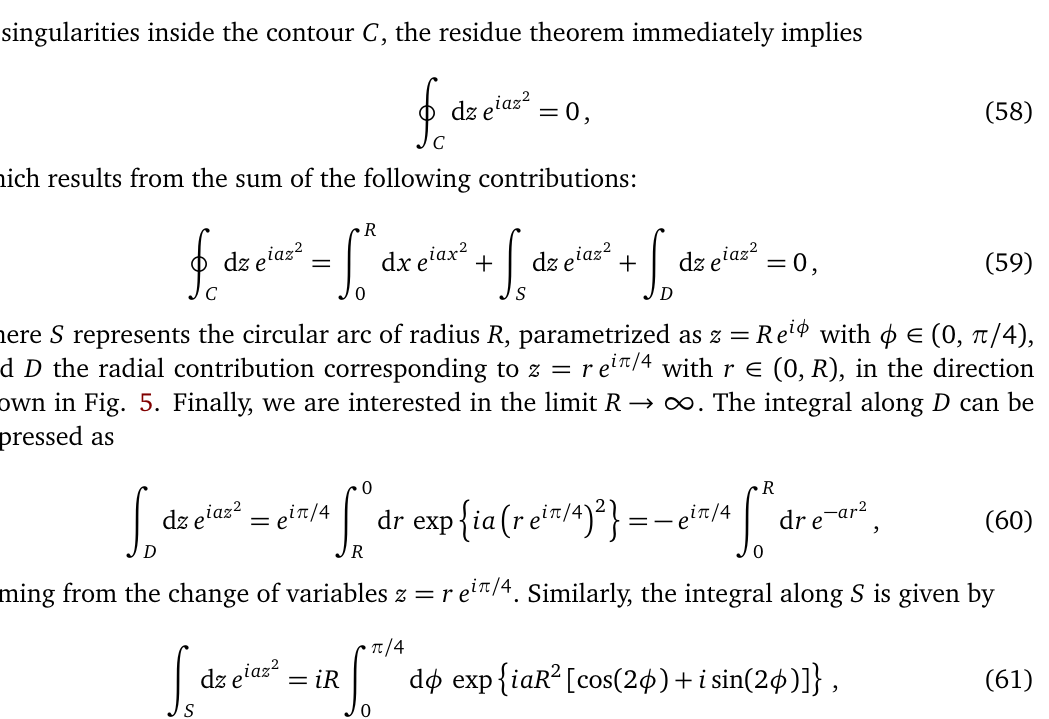
Figure 5: Integration contour C of Eq. (57). C consists of a circular section of angle π/ 4 and radius R , including the arc S and the segment D , in addition to the segment [ 0, R ] on the real